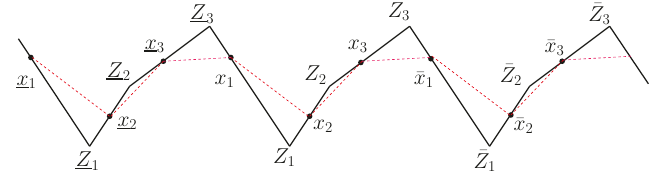
Figure 2. Momentum twistor space picture for the dual periodic Wilson line configuration for the three-point form factor. The red dashed line corresponds to the x -configuration in figure 1.